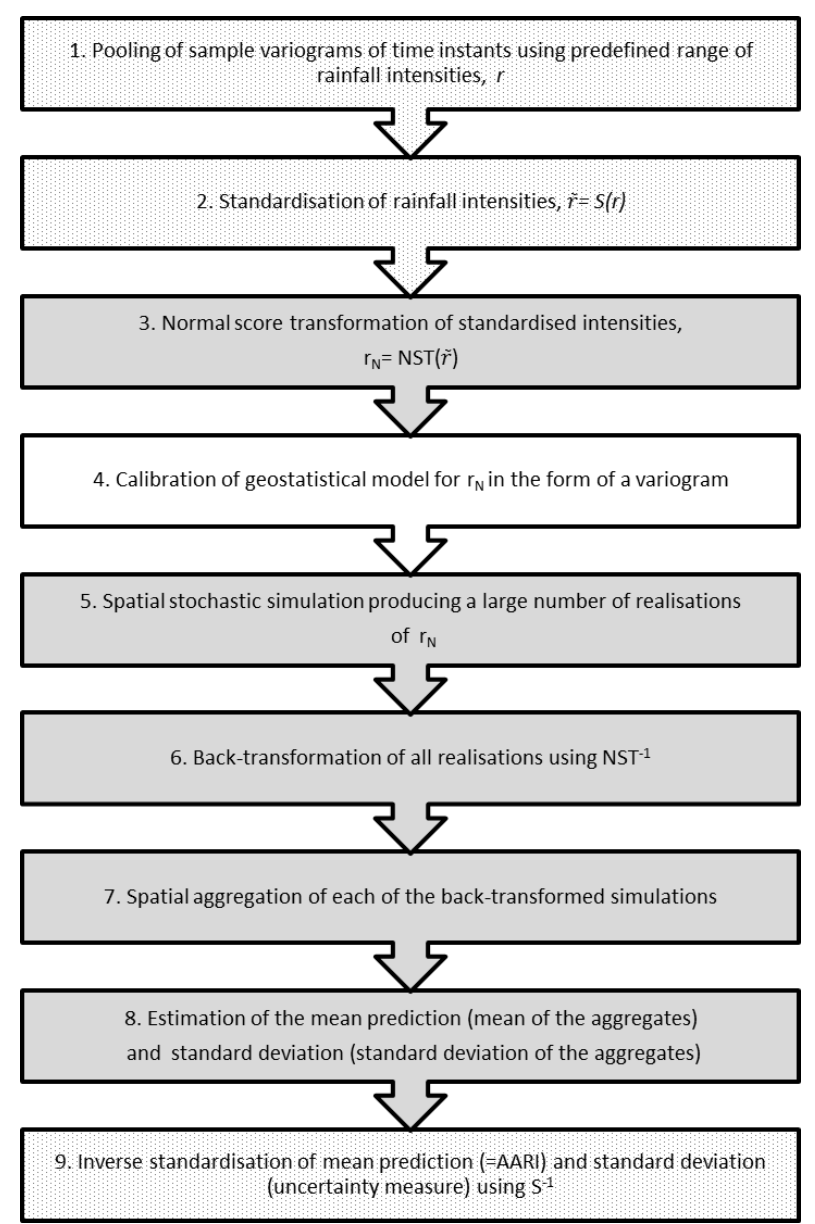
Figure 4. Step-by-step procedure developed in this study to predict AARI and associated level of uncertainty. Boxes highlighted in dots indicate the steps to resolve the problem of scarcity in measurement locations, grey boxes show the steps introduced to address non-normality of rainfall